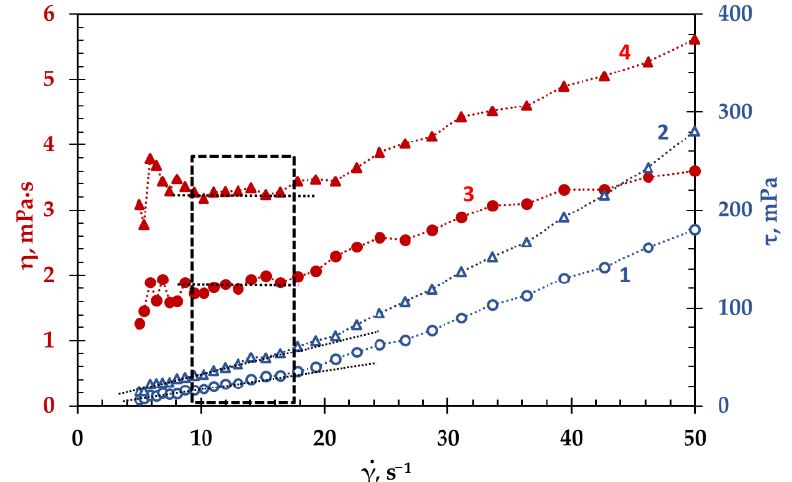
Figure 2. The flow (blue lines) and viscosity (red lines) curves of the (LiF - NaF - KF) eut (1, 3) at 1023 K and (NaF - KF) eut - 15NdF 3 (2, 4) at 1273 K.